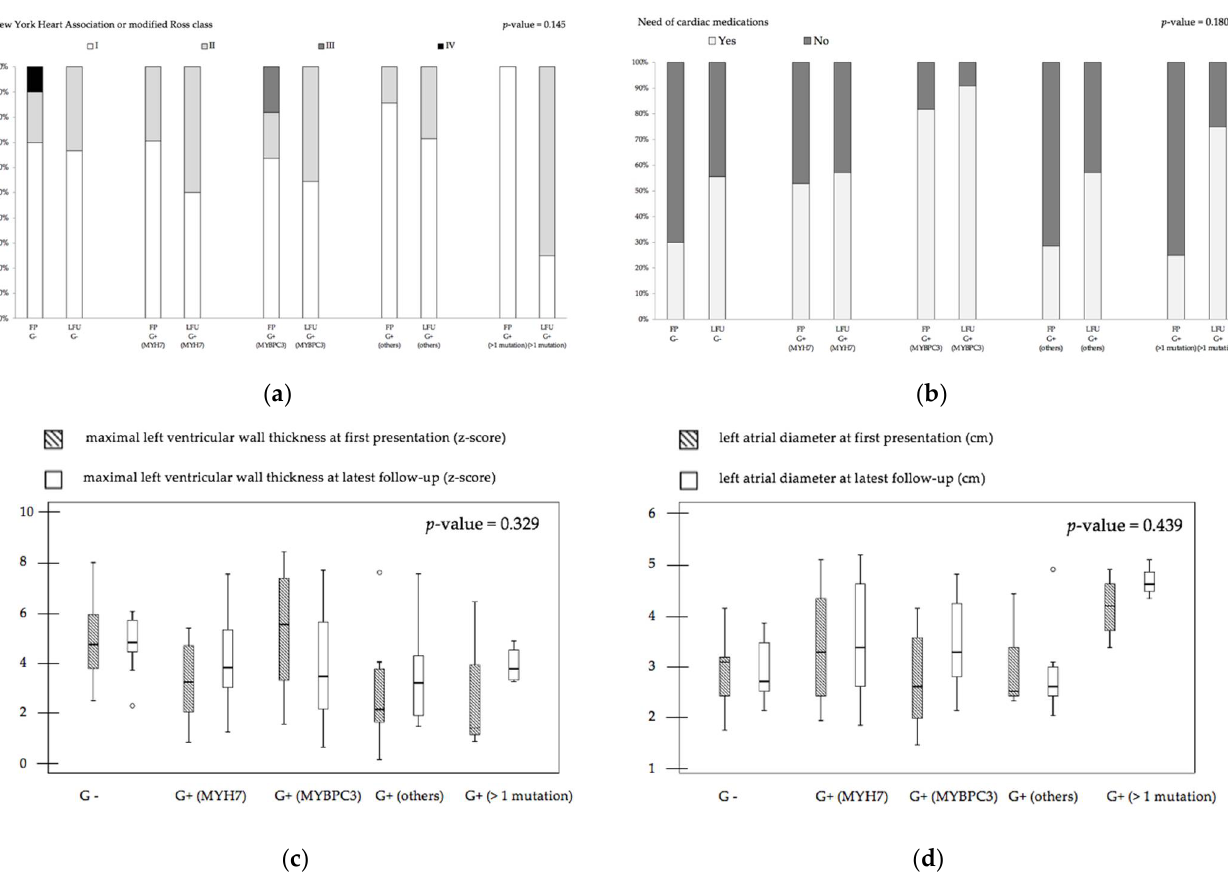
Figure 5. Disease progression Part I. Clinical outcome parameter of pediatric onset HCM patients are presented by the ( a ) New York Heart Association or modified Ross class and by ( b ) the need of cardiac medications. Imaging parameters are presented by ( c ) maximum myocardial wall thickness and by ( d ) the left atrial diameter measured by transthoracic echo- cardiography. p -values were calculated with the non-parametric Kruskal–Wallis test. The delta of the respective parameter between first presentation (FP) and last follow up (LFU) did not differ between consecutive groups. G−: genotype-negative patients, G+ MYH7: genotype-positive patients with β-myosin heavy chain single-mutation, G+ MYBPC3: genotype-pos- itive patients with myosin binding protein C single-mutation, G+ others: genotype-positive patients with cardiac troponin T2, cardiac troponin I3, α tropomyosin and myosin light chain 2 single-mutations, G+ multiple mutation: genotype-posi- tive patients with compound mutations, °: outliers. 4. Discussion The purpose of this study was to investigate genotype–phenotype association in pa- tients with childhood onset HCM, depending on mutation type and count. Furthermore, we examined disease progression in these individuals, especially the dependency of dif- ferent mutations on disease severity. Genotype–phenotype relationship and predictors for disease progression in adult patients have been previously described, but precise data of children with HCM are rare. This study adds to the body of evidence about genotype– phenotype association in patients diagnosed with HCM during childhood. The current study revealed no differences with regard to clinical disease course and myocardial pathology comparing patients carrying a single mutation in distinct genes. These findings are in line with other studies mostly including adult HCM patients stating that mutation type is negligible for clinical phenotype and prognosis prediction [22–24]. Van Driest et al. categorized genotype-positive tested patients in myofilament-based sub- groups for comparison [25]. Concomitant to the results of the current study, researchers faced difficulties to detect clear differences in clinical phenotype. Similar findings of phe- notypic independency and tremendous genetic heterogeneity were also determined by comparing MYH7 with MYBPC3 mutation carrier in a study cohort of adults with HCM [26]. In contrast to those findings, authors of a pediatric HCM investigation suggest that pathogenic variants in the MYH7 gene might have a greater impact on phenotypic sever- ity and worse clinical outcome [27]. Earlier disease onset and greater severity of HCM phenotype was identified more frequently in patients with MYH7 variants [27]. One rea- son for the absence of genotype–phenotype association in our study could be the small sample size of pediatric HCM patients. However, HCM is, in general, caused by rare mu- tations and the prevalence of variability of mutations in particular gene domains is low, which remains the challenge of detecting clear genotype–phenotype correlation [18]. Taken together, no clear genotype–phenotype relationship in pediatric HCM patients has been established based on current data. More so, data suggest that multiple other non-ge- netic factors and gene modifications are playing a pivotal role in phenotypic expression [22].